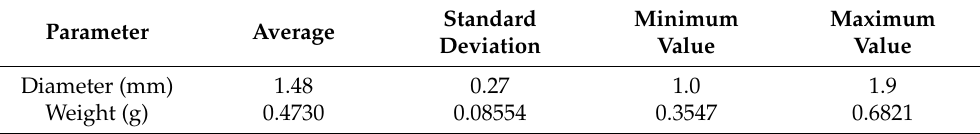
Table 1. Description of the seeds used in the study. Parameter